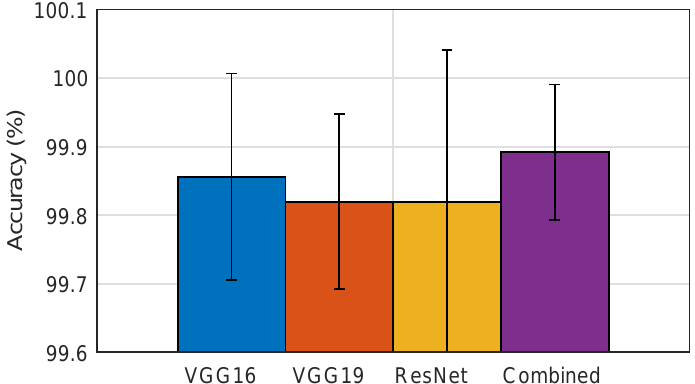
Figure 5. Comparison of recognition results between different convolution networks on the Flavia dataset.